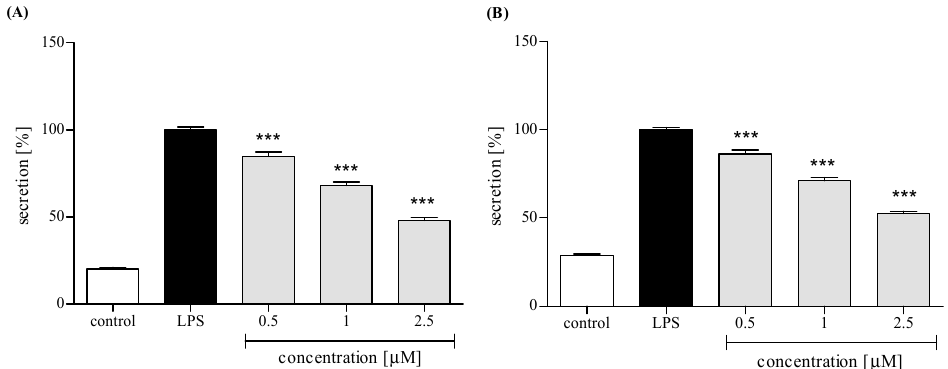
Figure 5. Inhibitory effects of trans -12-OPDA, at concentrations of 0.5, 1.0, and 2.5 μ M, on IL-8 ( A ) and TNF α ( B ) secretion by LPS-stimulated human neutrophils. Statistical significance *** p < 0.001, with reference to a stimulated control.